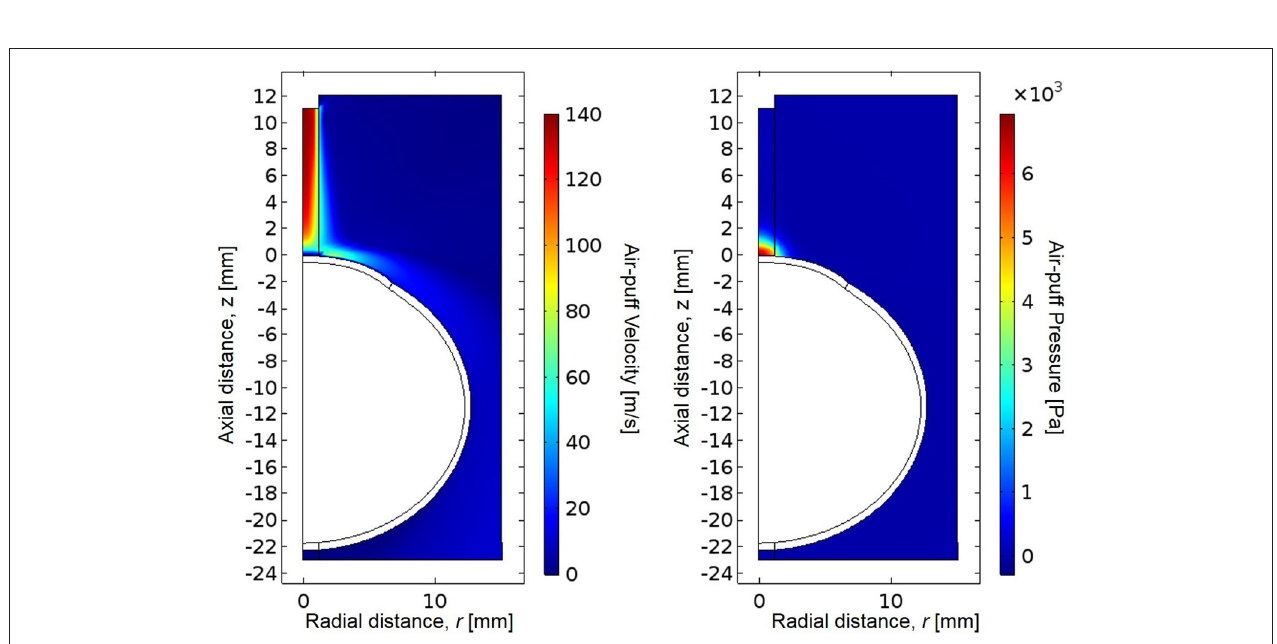
FIGURE 5 | Simulated CorVis ST air-puff velocity profile (left) and pressure profile (right) , which serves as the load on the anterior boundary of the globe. The simulation profiles agree within 2% of experimental measurements using hot-wire anemometry from Roberts et al. (2017).